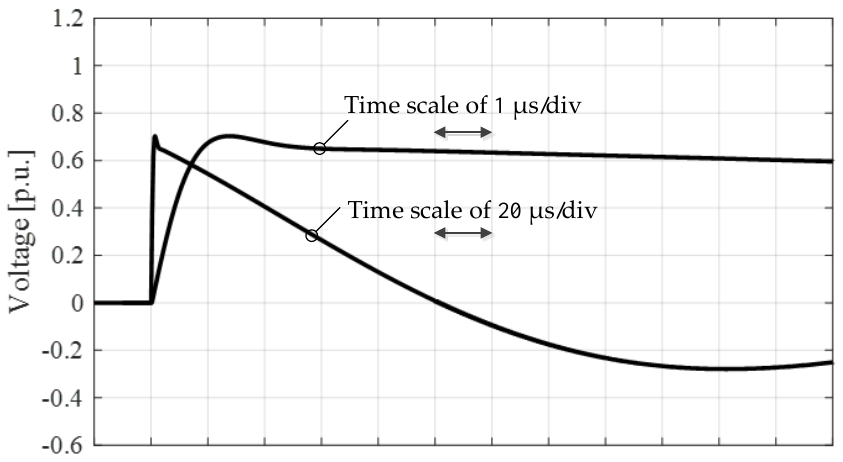
Figure 8. Generated waveform of Case 1 in Table 4 and by the proposed approach.